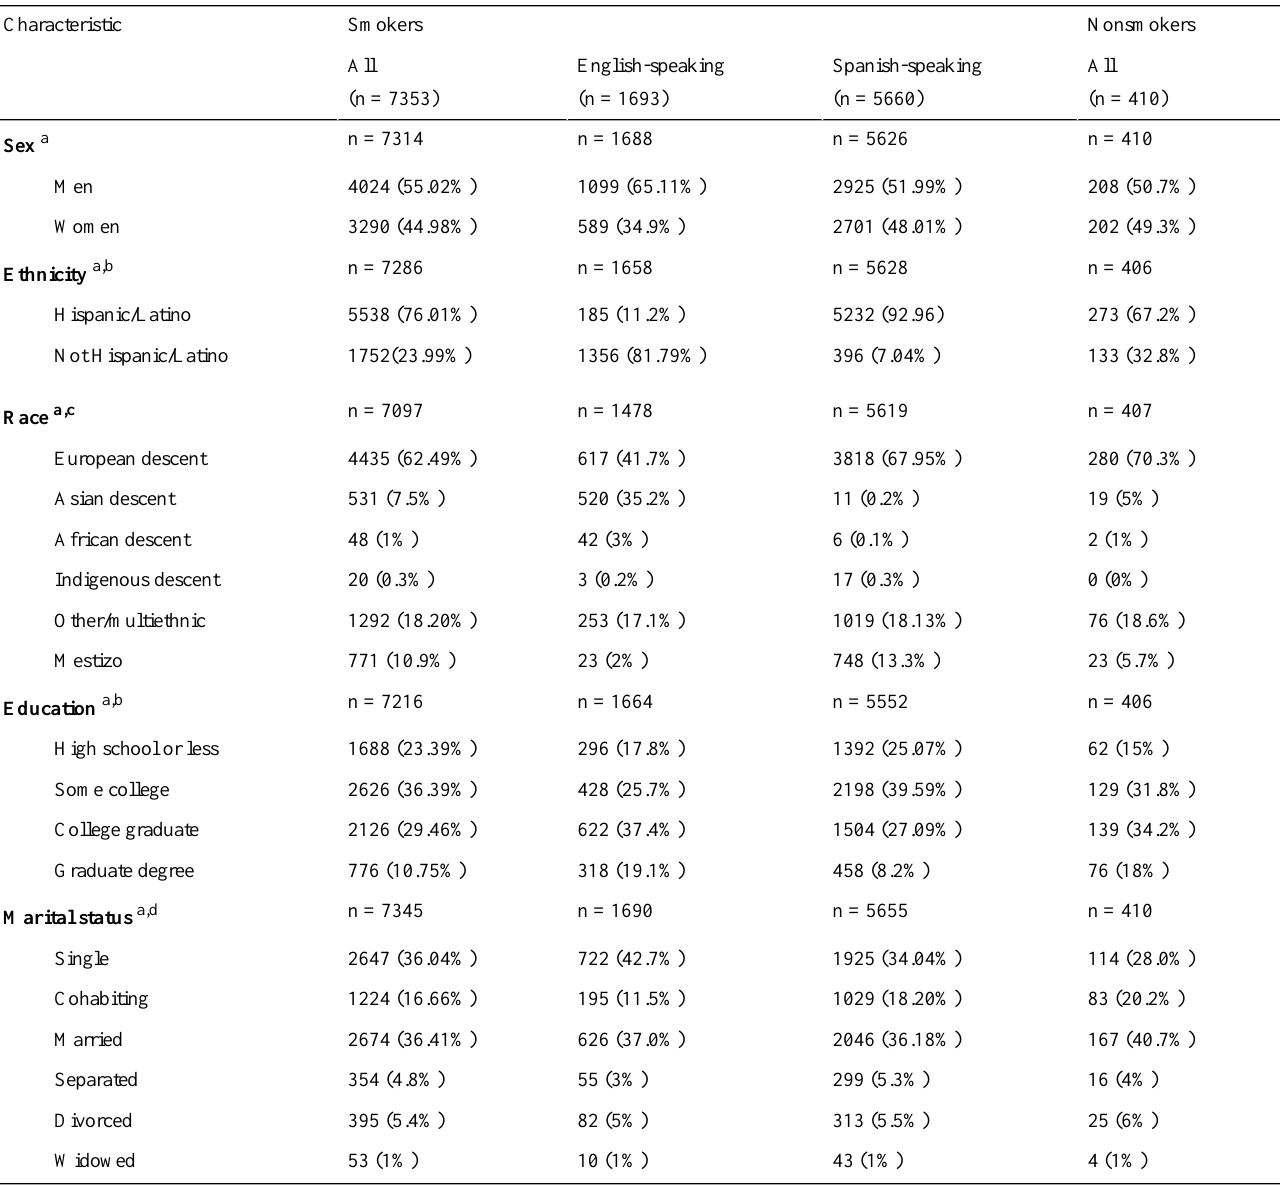
Table 1. Demographics of consenting participants who completed baseline